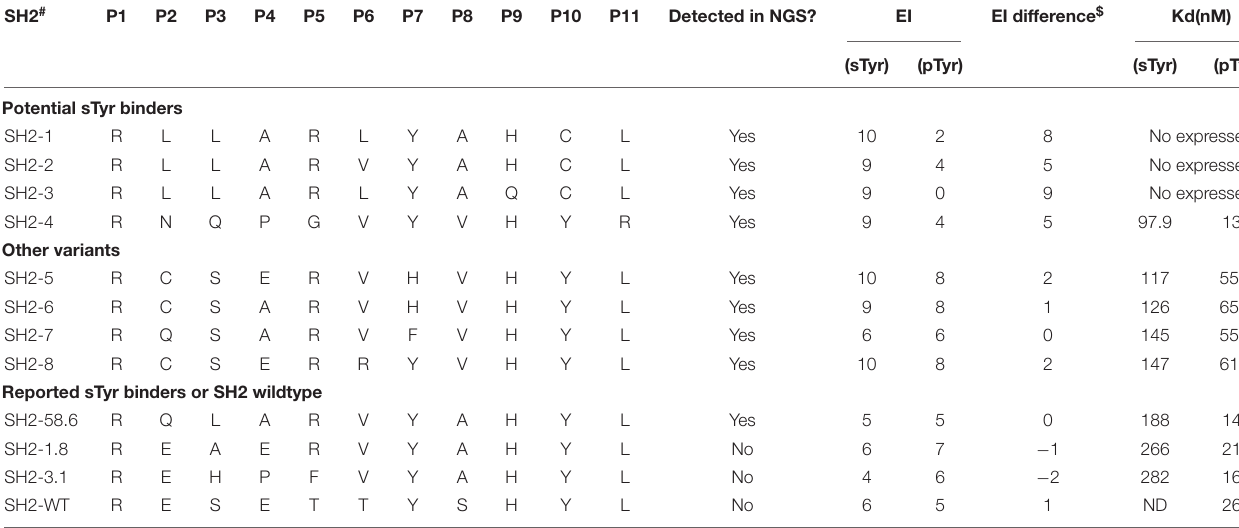
TABLE 1 | Residues at the evolvable positions and EI values and binding affinities of Src Homology 2 (SH2) variants to phosphotyrosine (pTyr) and sulfated tyrosine (sTyr) peptides. SH2 # P1